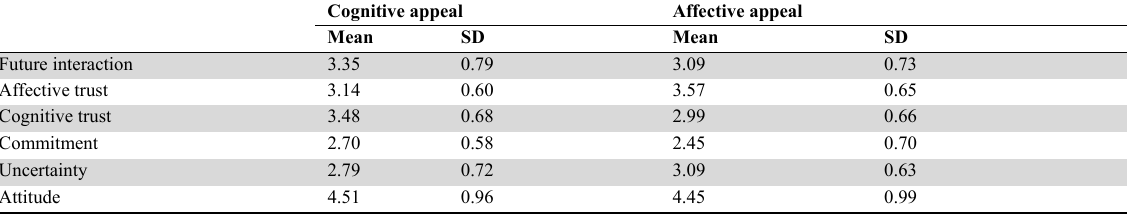
Sample means, and standard deviations using factor